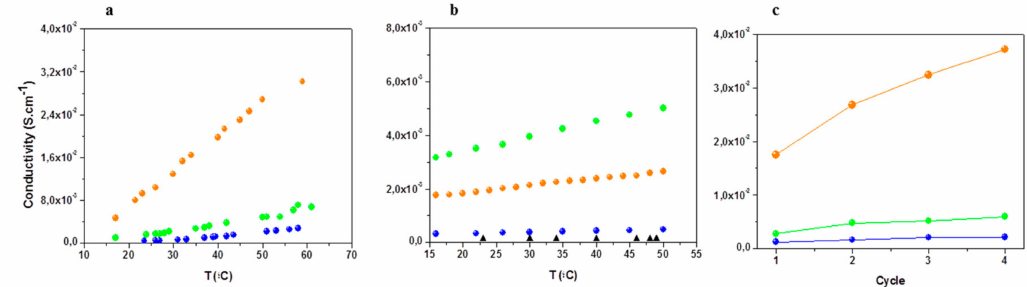
Figure 3. Conductivity profile of the ( a ) pristine nanofluids; ( b ) 95% ( w / w ) aqueous solutions of the Cdots / [Bmim]Cl in blue and Cdots / [Bmim]Cl / [Tmi][Trif] in green CdotsCHI / [Bmim]Cl / [Tmi][Trif] in orange, and [Tmi][Trif] in black. ( c ) Conductivity values obtained at 50 ◦ C after each heating and cooling cycle of the three pristine